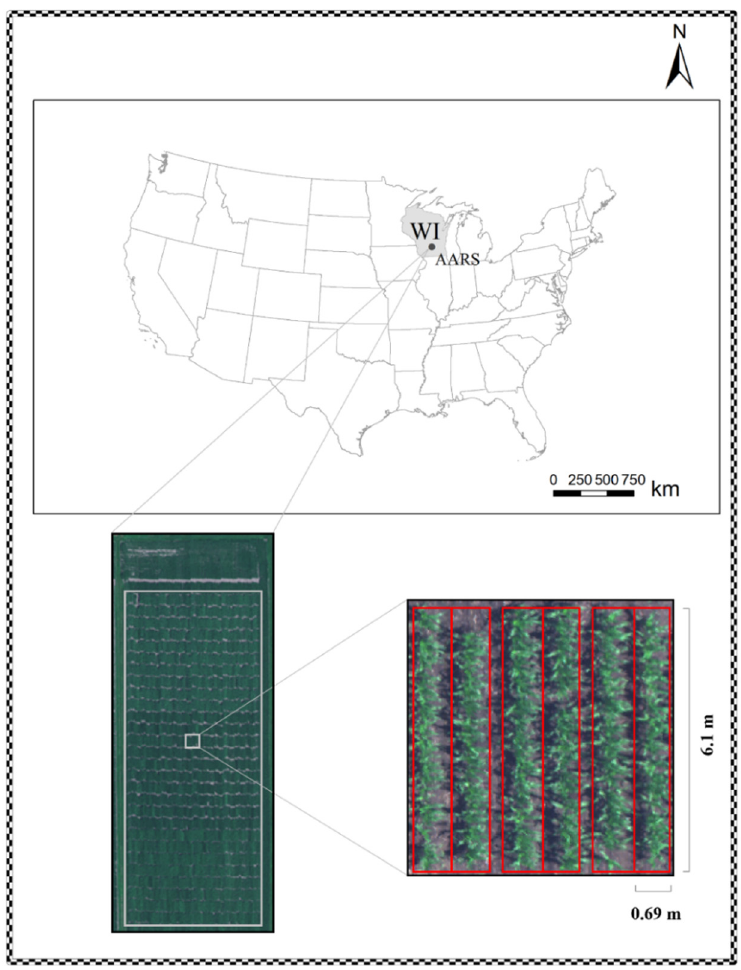
Figure 1. Maize breeding experimental trial at AARS.